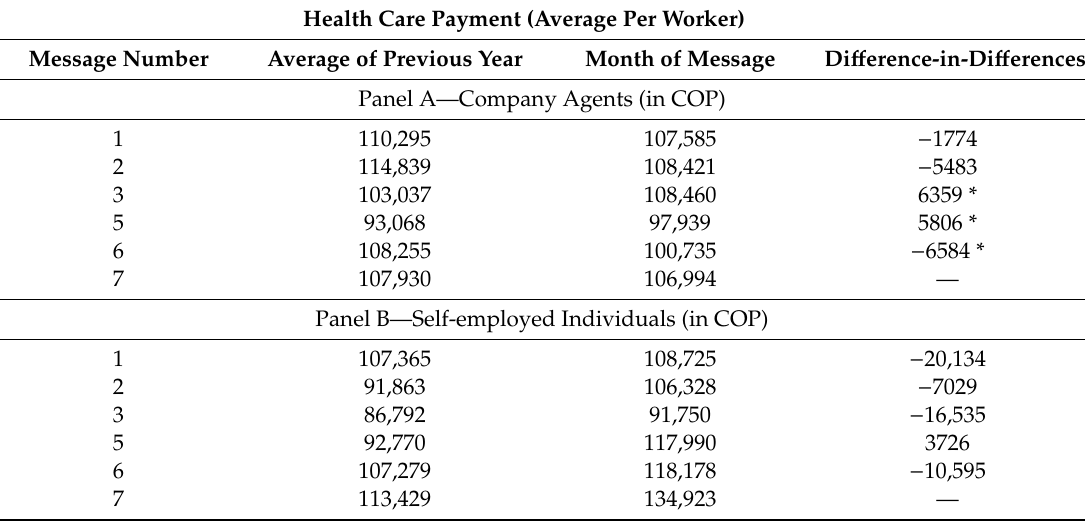
Table 2. Health Care Payments with “Neutral Message 7 as Control Group”—